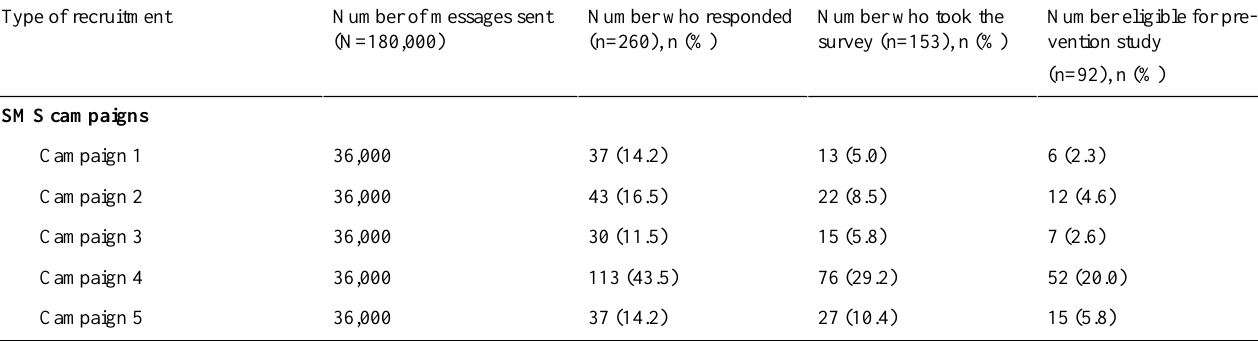
Number eligible for